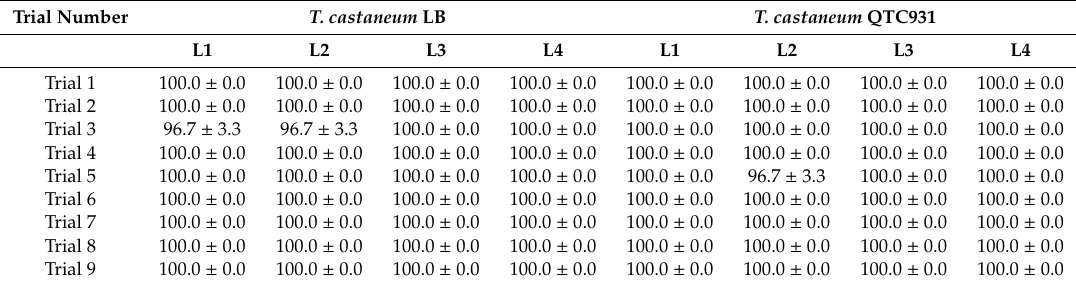
Table 2. Mean mortality ( ± SE) of two populations of T. castaneum (LB, QTC931), with di ff erent susceptibility to phosphine, exposed to nitrogen in nine di ff erent trials (for conditions for each trial, see Table 1). For each trial, vials with insects were placed in four di ff erent locations (L1–L4, see Table 1).